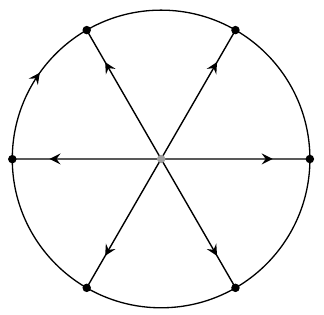
Figure 11 . Simple wheel at l = 6. The black blobs are integrated over, while the gray blob in the center of the (cid:12)gure is the external point of F l;N ( z; w ) left over after